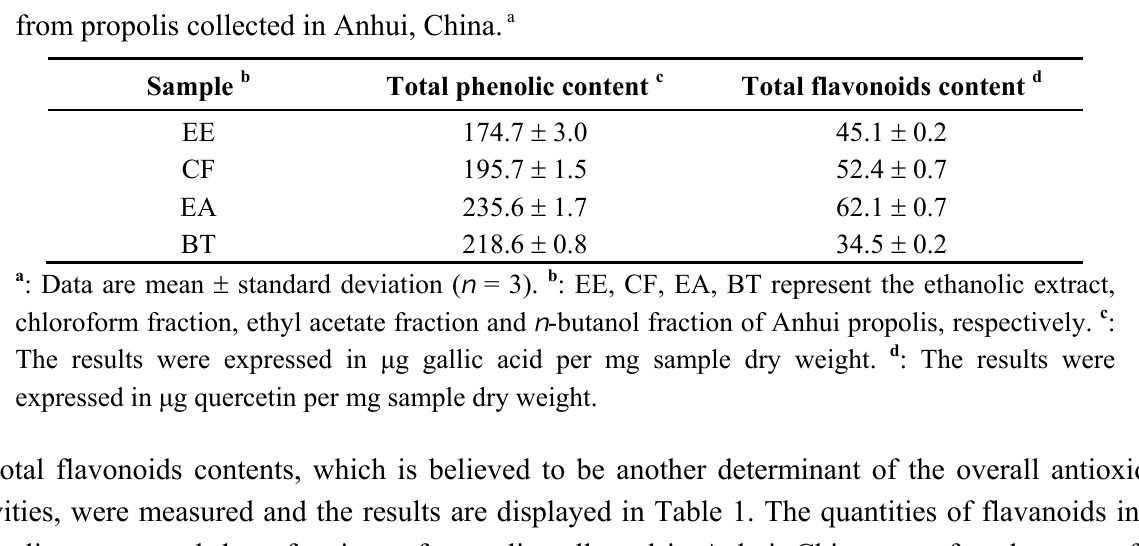
Table 1. Total phenolic and total flavonoids content of ethanolic extract and three fractions from propolis collected in Anhui, China. a